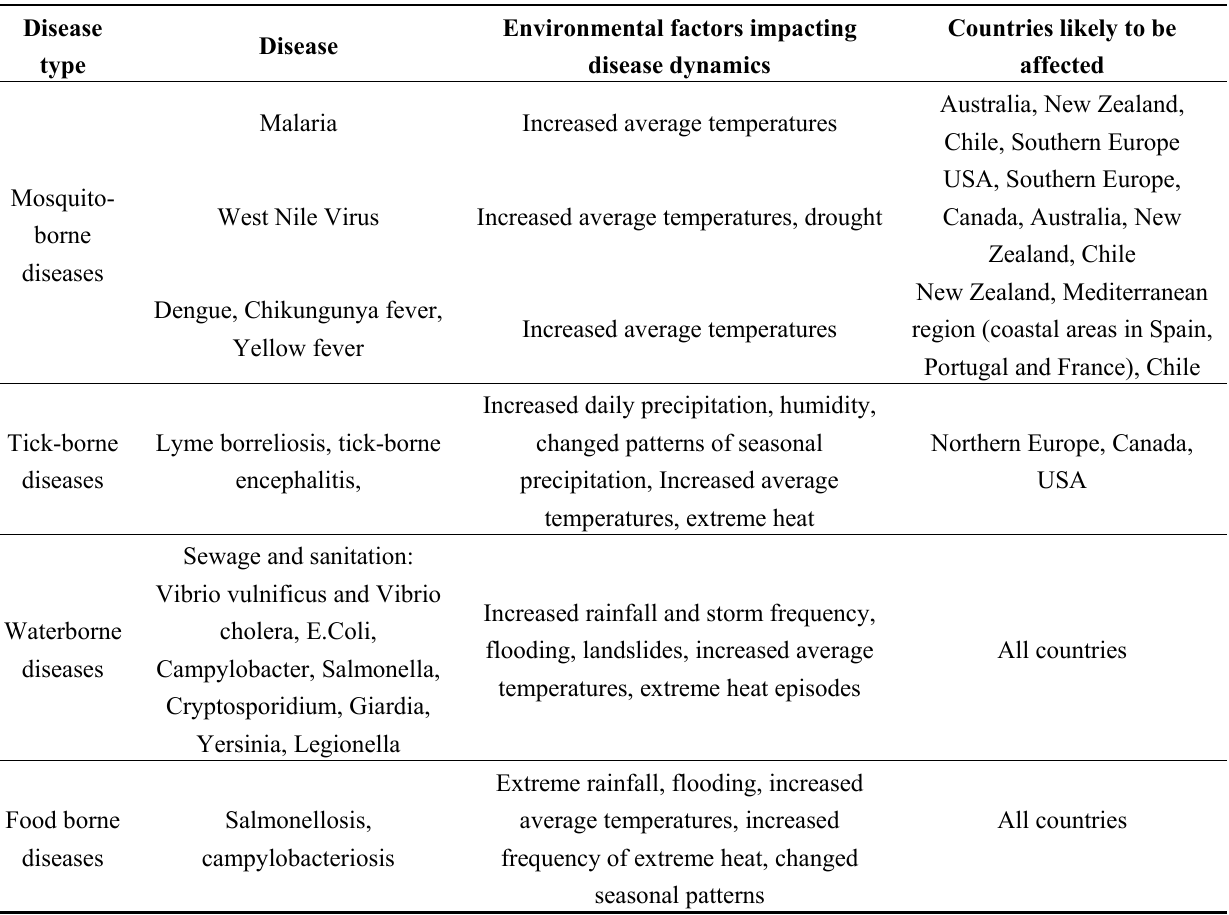
Table 1. Climate-Dependant infectious diseases and sample countries likely to experience health hazards linked to changes in disease exposure. Inspired from ECDC 2010